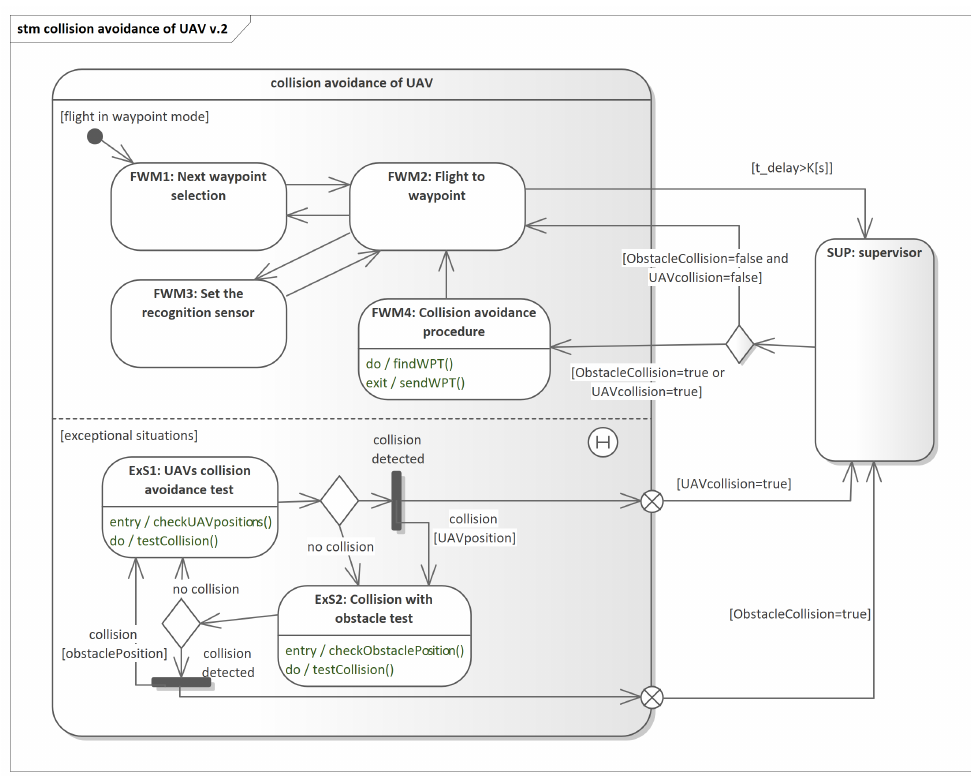
Figure 3. State machine diagram for collision avoidance of two UAVs. Model for two core units processor. Actions within the states are